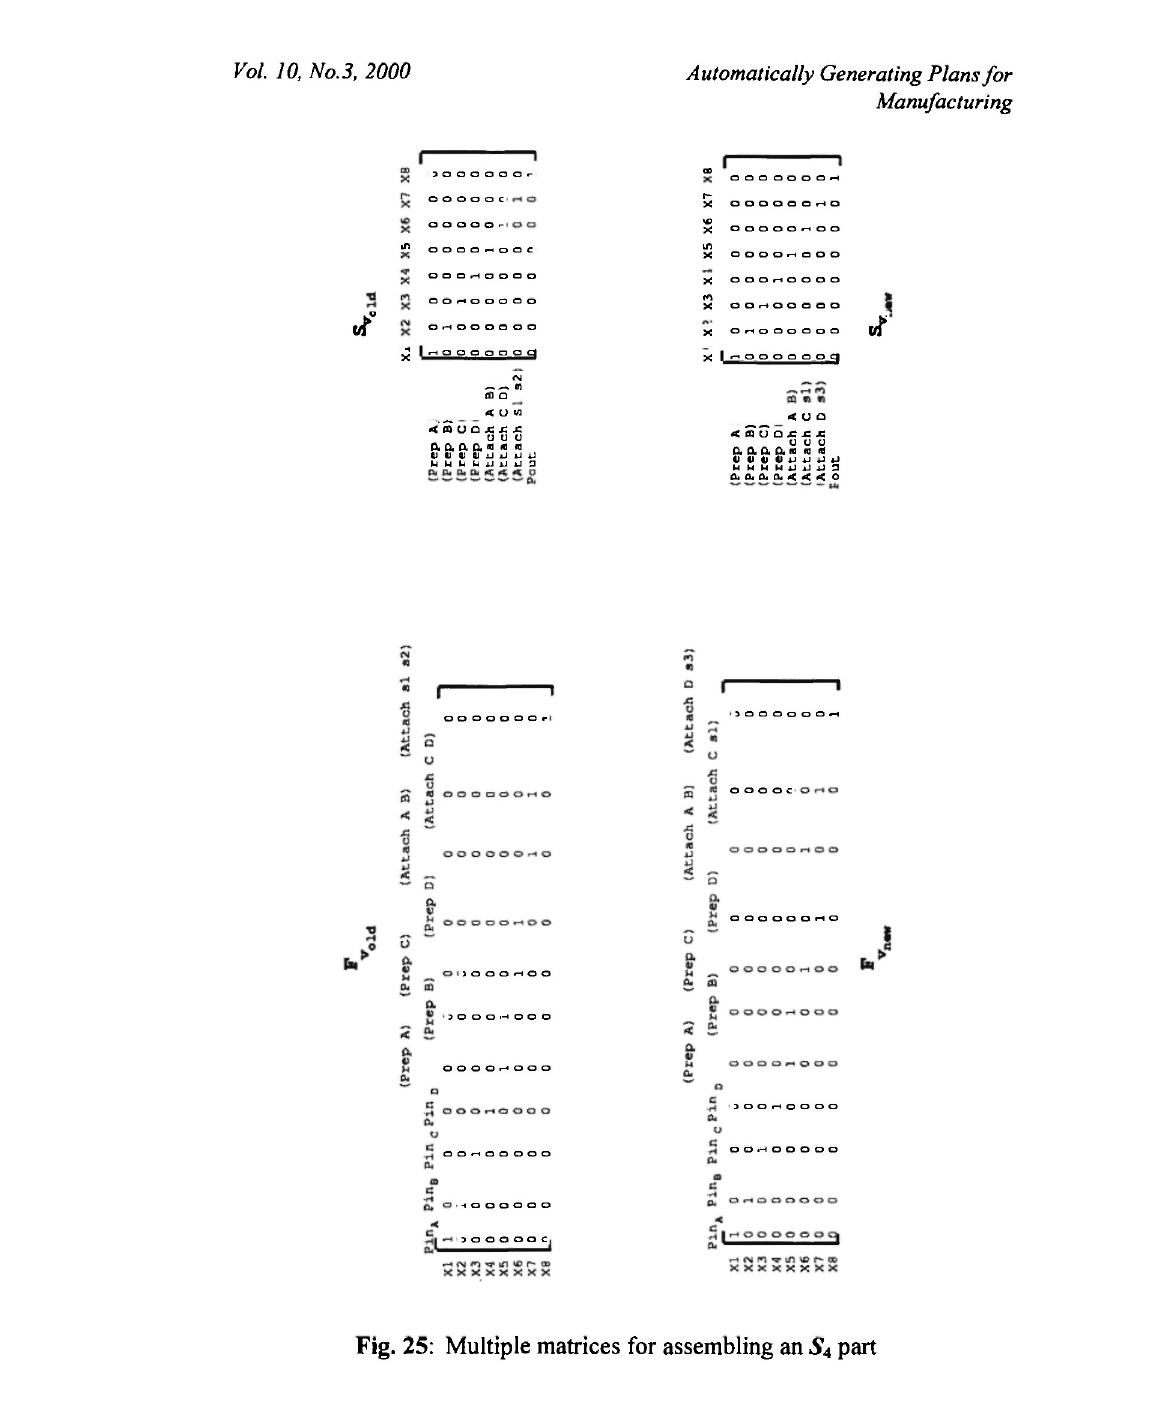
Fig. 25: Multiple matrices for assembling an S 4 part